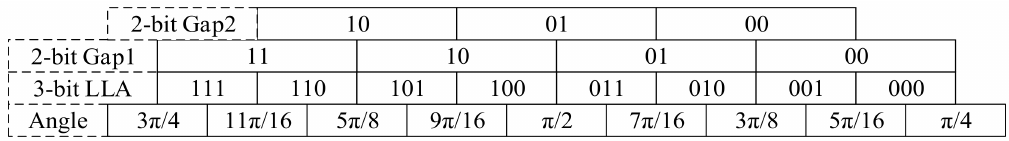
Figure 8. LLA grouping